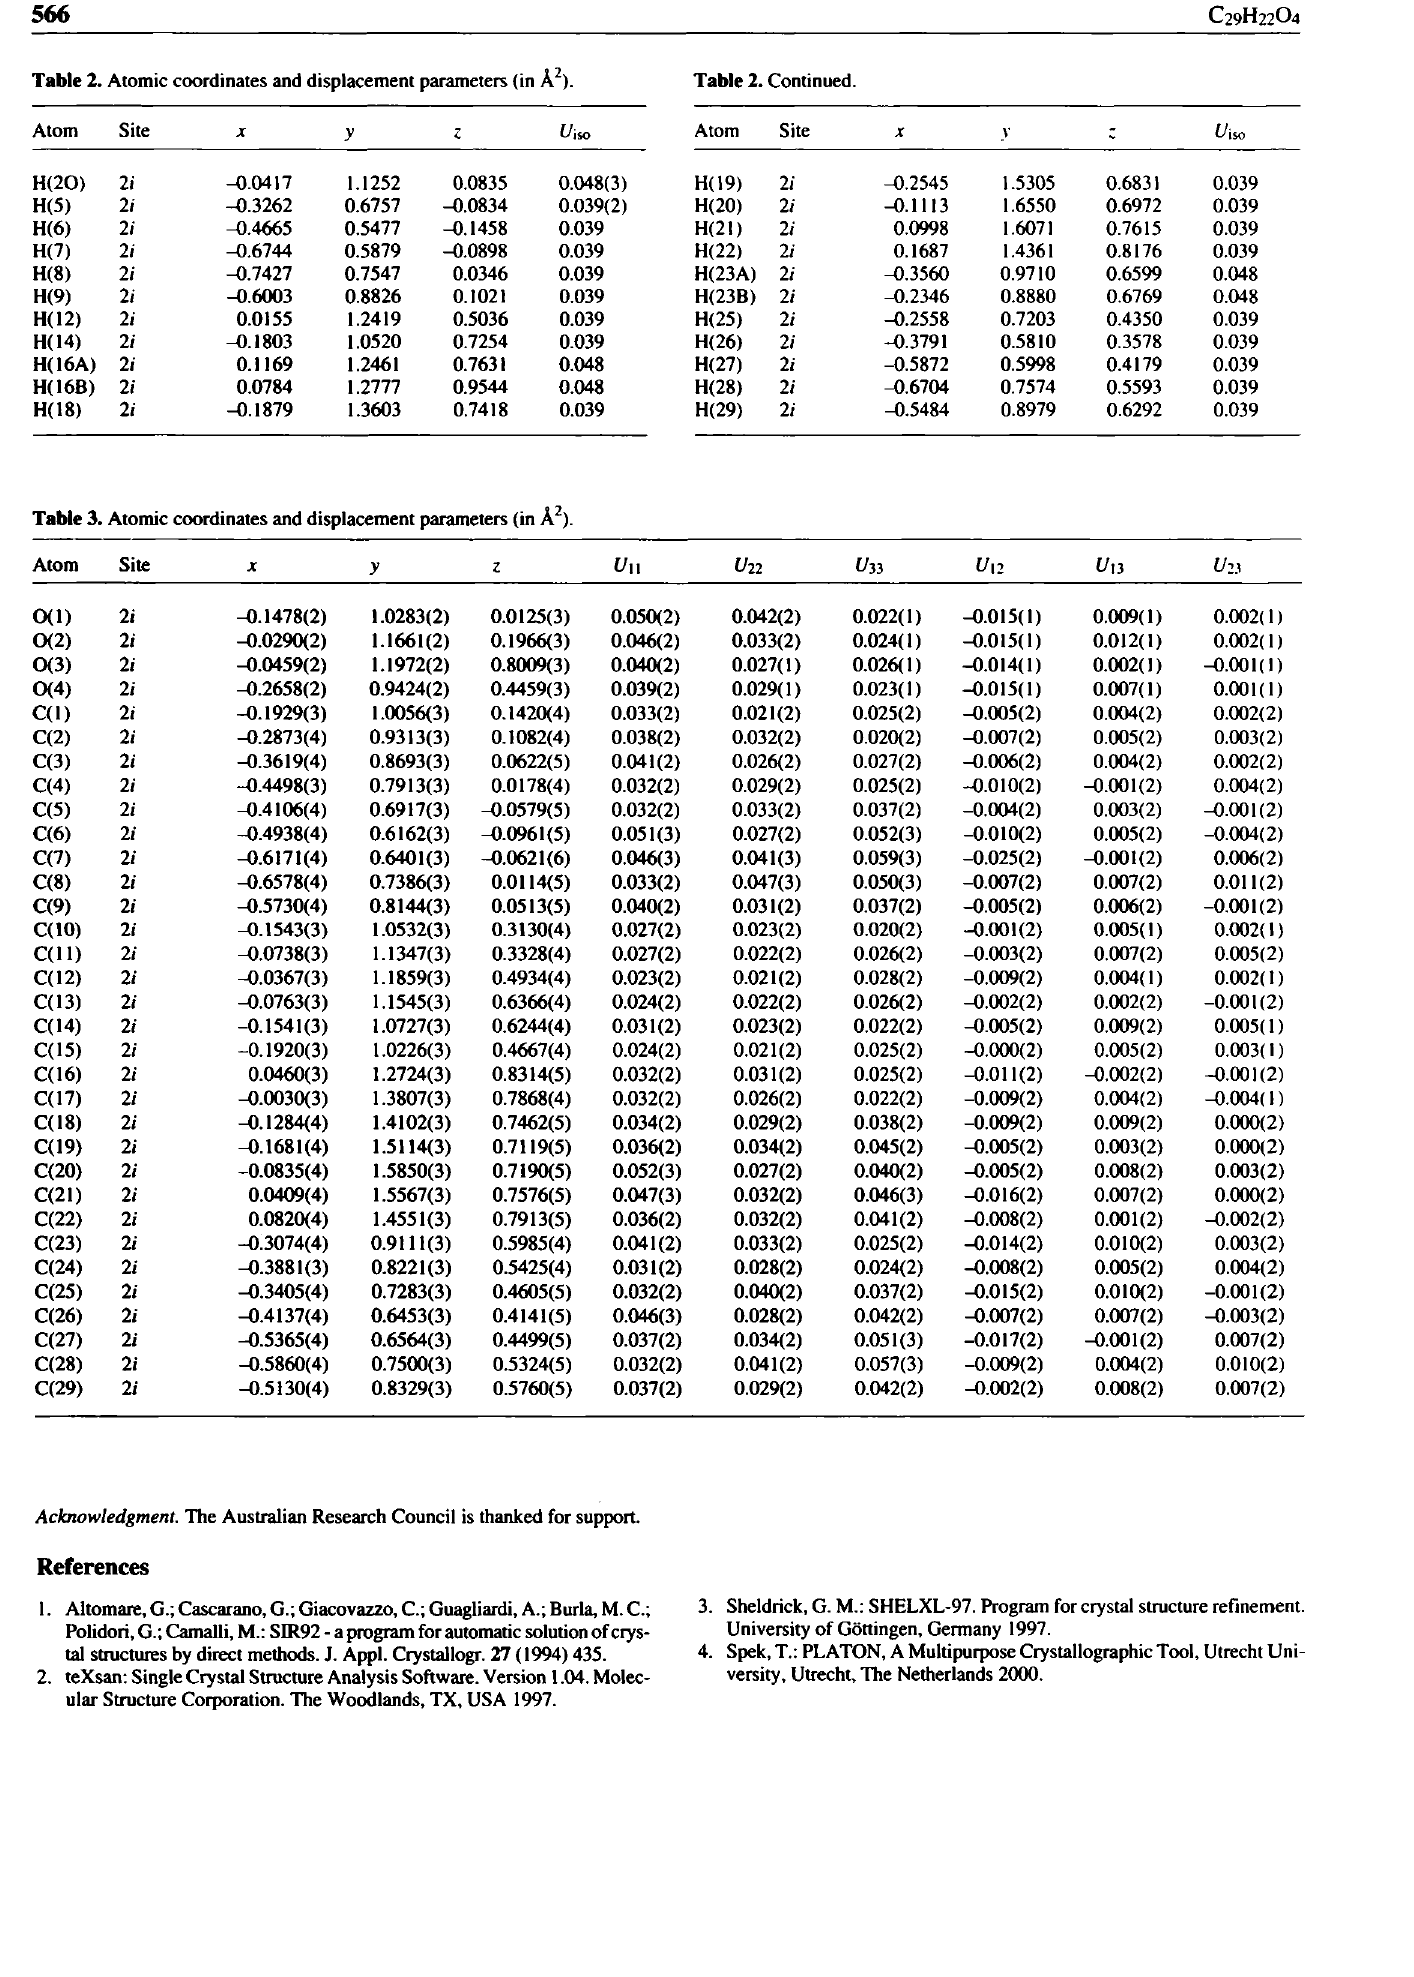
Table 2. Atomic coordinates and displacement parameters (in A 2 ).